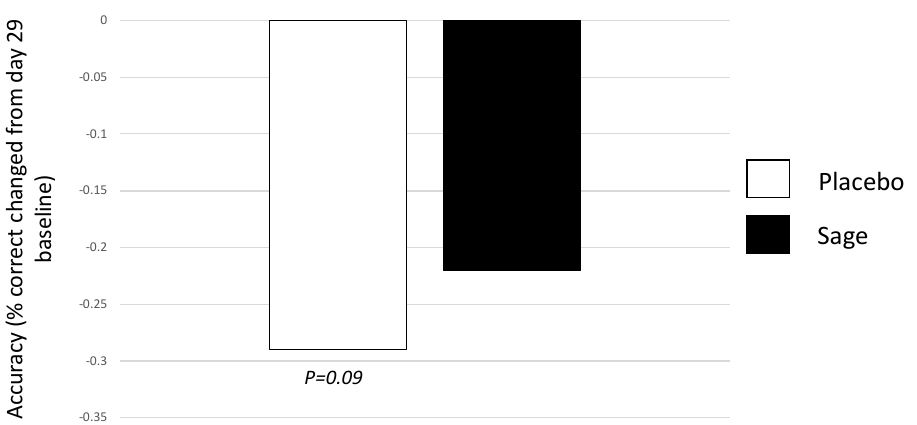
Figure 12. Acute effect of treatment on day 29 for overall accuracy: a trend towards a significant main effect of treatment ( p = 0.09) was observed for overall accuracy on day 29, where accuracy was poorer (as compared to pre-dose performance on the same day, day 29) in the placebo condition as compared to the sage condition.